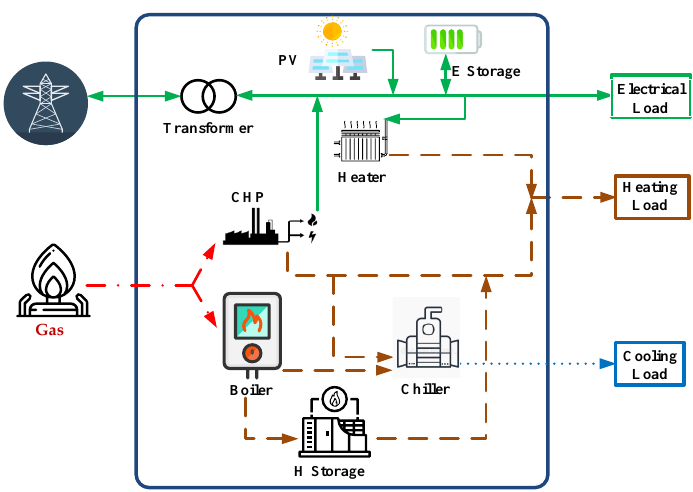
Figure 3. Illustration of the EH modelled based on energy flow.